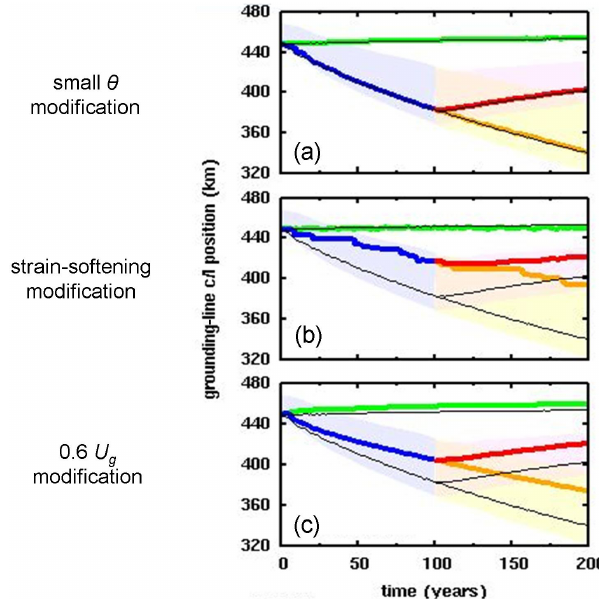
Figure B1. Along-fjord centerline position (km) of grounding lines in the MISMIP + Ice1 experiment (Cornford et al., 2020) (a) with small θ modification described in Sect. B1, (b) with strain-softening modification described in Sect. B2, and (c) with 0 . 6 U g modification described in Sect. B3. Thick colored lines: as in the main paper ex- cept with one of the above modifications. Thin black lines: as in the main paper with no further modification. Green: control (con- tinuation of spin-up with zero oceanic melt). Blue and yellow: with oceanic melt perturbation. Red: with oceanic melt reset to zero af- ter year 100. Shaded regions show the envelopes for the “main sub- set” of MISMIP + models, copied from Cornford et al. (2020, their Fig.